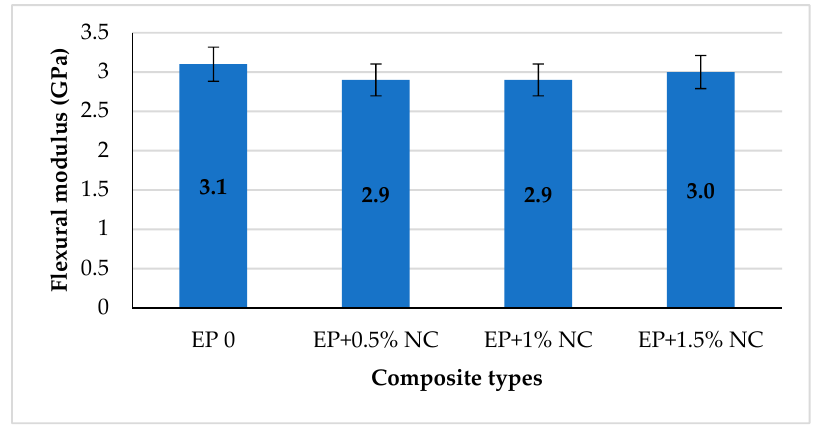
Figure 9. Flexural modulus for epoxy composites with NC.